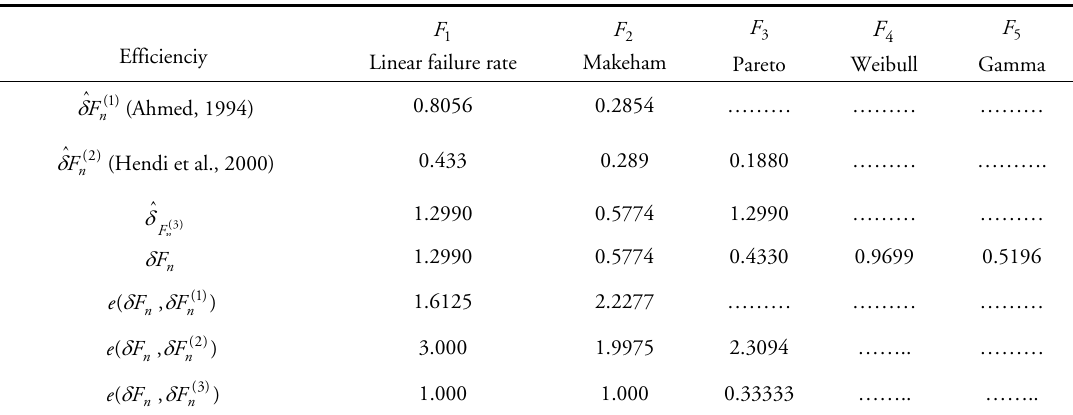
Asymptotic relative efficiency